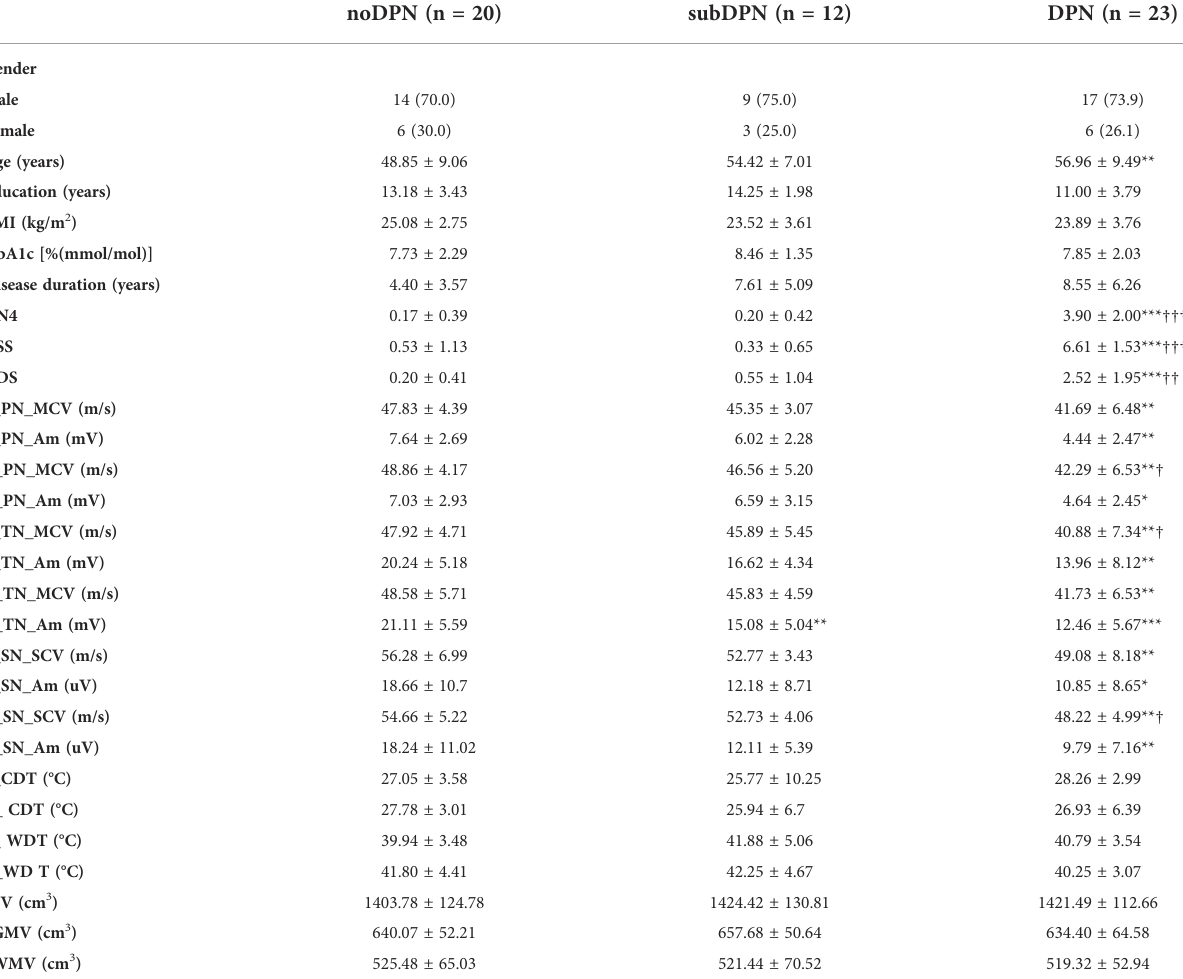
TABLE 1 Results of demographic characteristics and intracranial